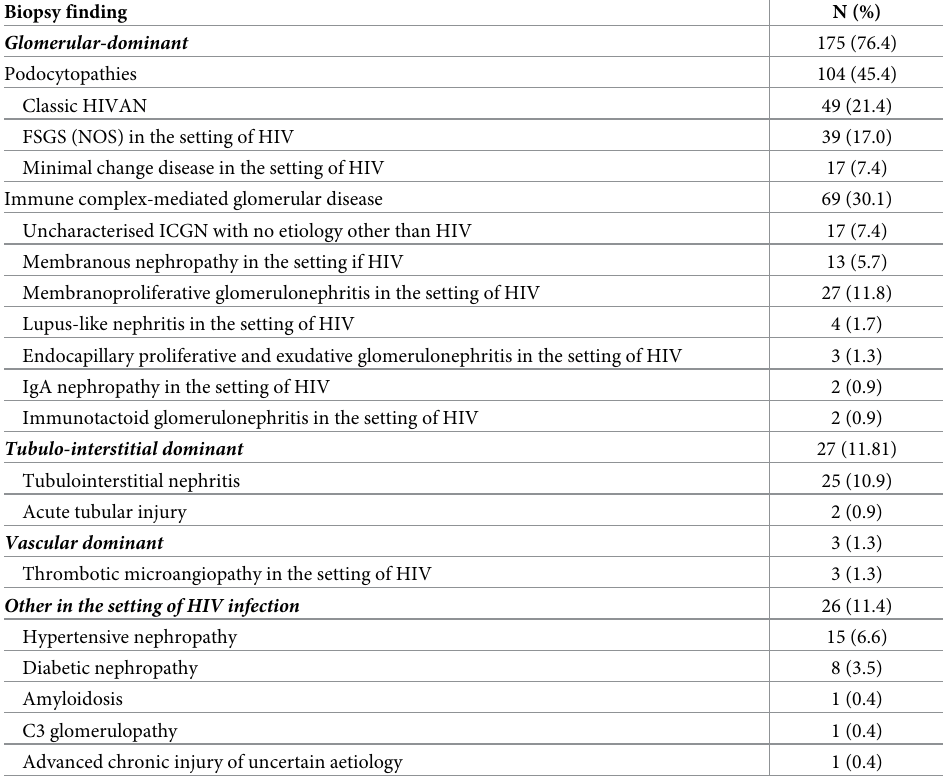
Table 5. Spectrum of biopsy findings in the 229 HIV positive patients with serial kidney function measurement. Biopsy